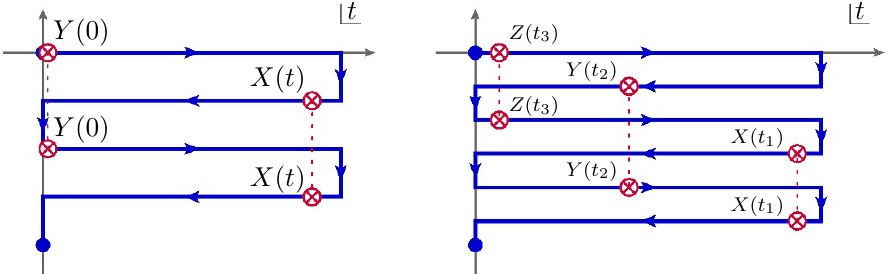
Figure 3 . Illustration of the 4- and 6-point out-of-time-ordered correlators that we consider.